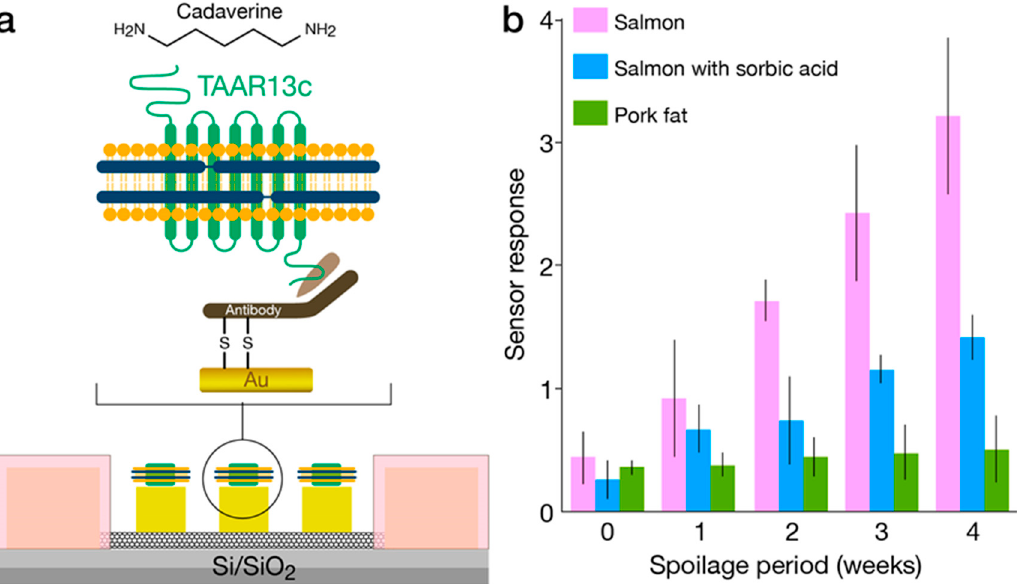
Figure 3. Nanodisc-based bioelectronic nose. ( a ) Diagram of the sensor showing carbon nanotube transistors. The nanodisc-embedded TAAR13c was immobilized onto gold floating electrodes by using a half fragment antibody as a linker. ( b ) The response to the target ligand volatile organic compound (VOC) cadaverine is shown. The percent change in device conductance after exposure to spoiled food samples exhibiting higher responses following prolonged spoilage periods. Adapted with permission from Yang et al. 2017. Copyright (2017) American Chemical Society.